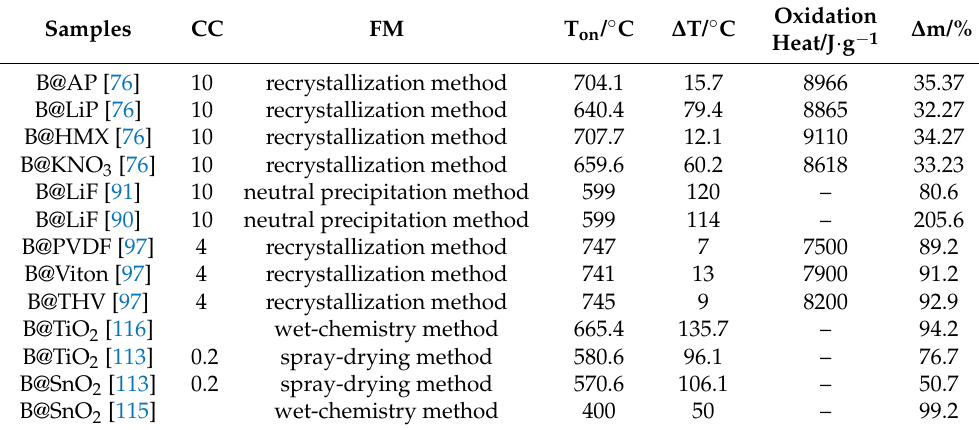
Table 4. Properties of common materials coated with boron powder.